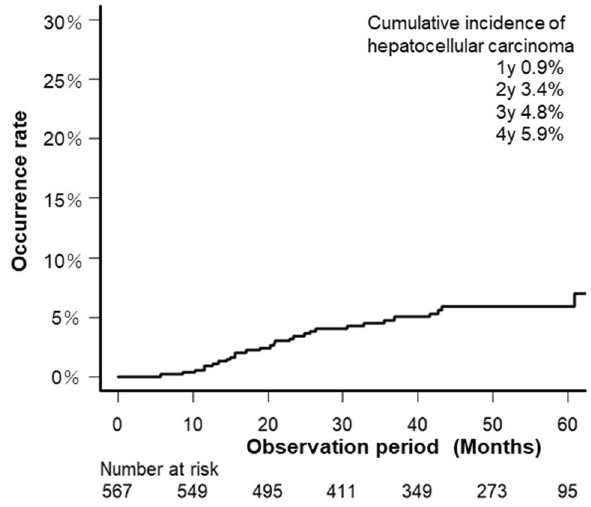
Figure 1. Cumulative incidence of hepatocellular carcinoma after IFN-free treatment. IFN, interferon.